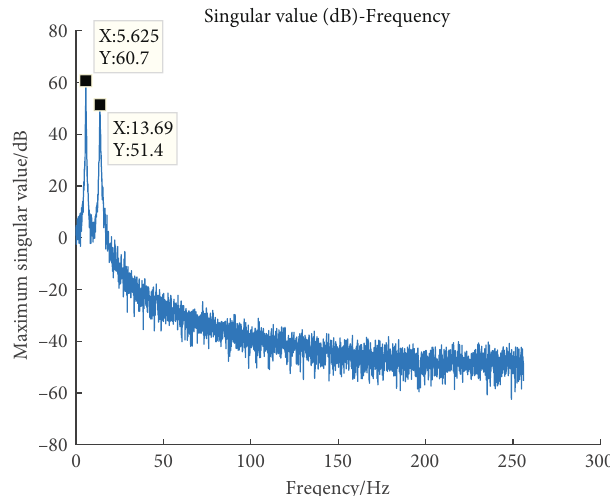
Figure 3: Maximum singular value curve.